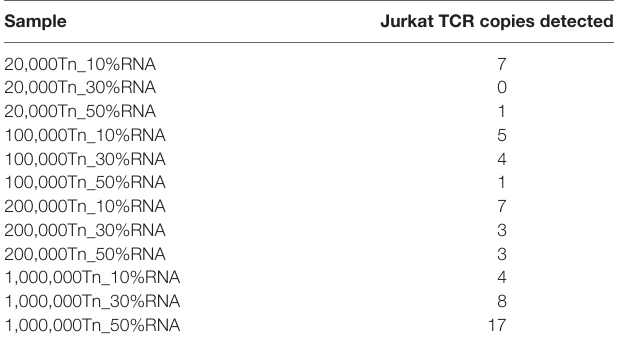
tABLe 1 | Spike-in Jurkat T cell receptor (TCR) RNA detection in naïve CD8 + T cells.